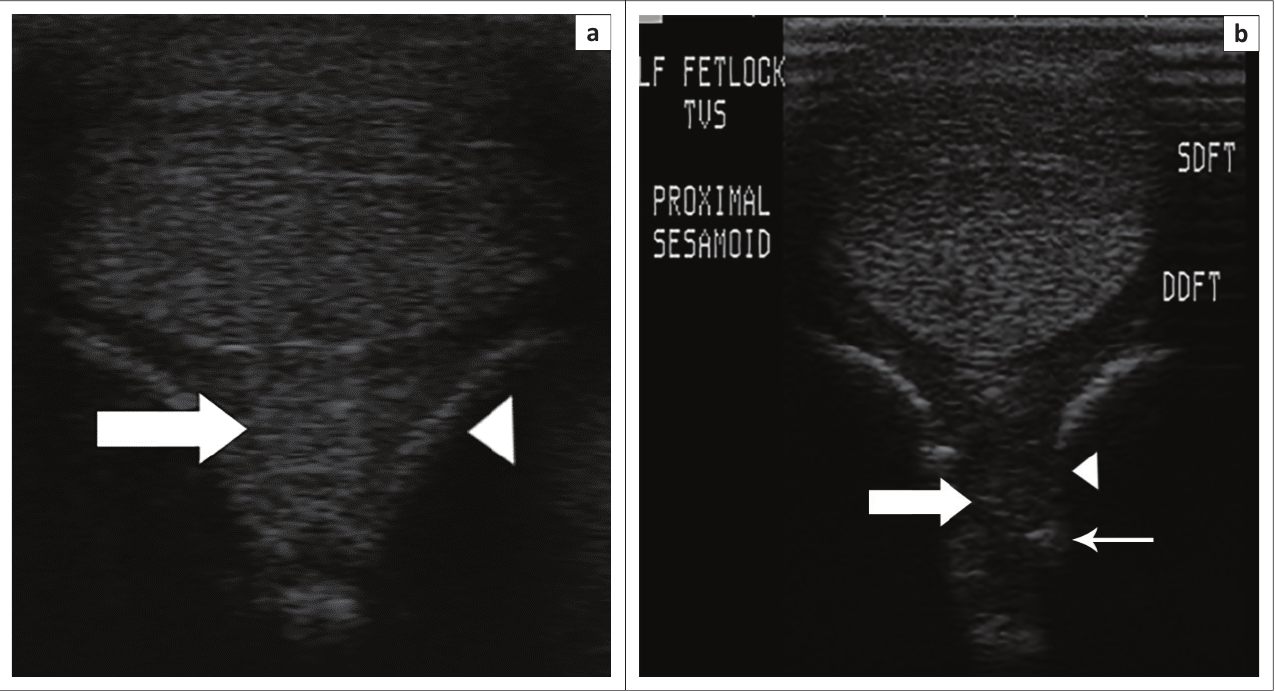
FIGURE 4: (a) Transverse ultrasound scans performed at the level of the palmar proximal sesamoid bones of the left forelimbs of a normal palmar ligament and sesamoid bones of an adult mixed breed horse (b) and a limb affected by axial sesamoiditis and palmar desmitis in an adult Thoroughbred horse. Lateral is to the left of the